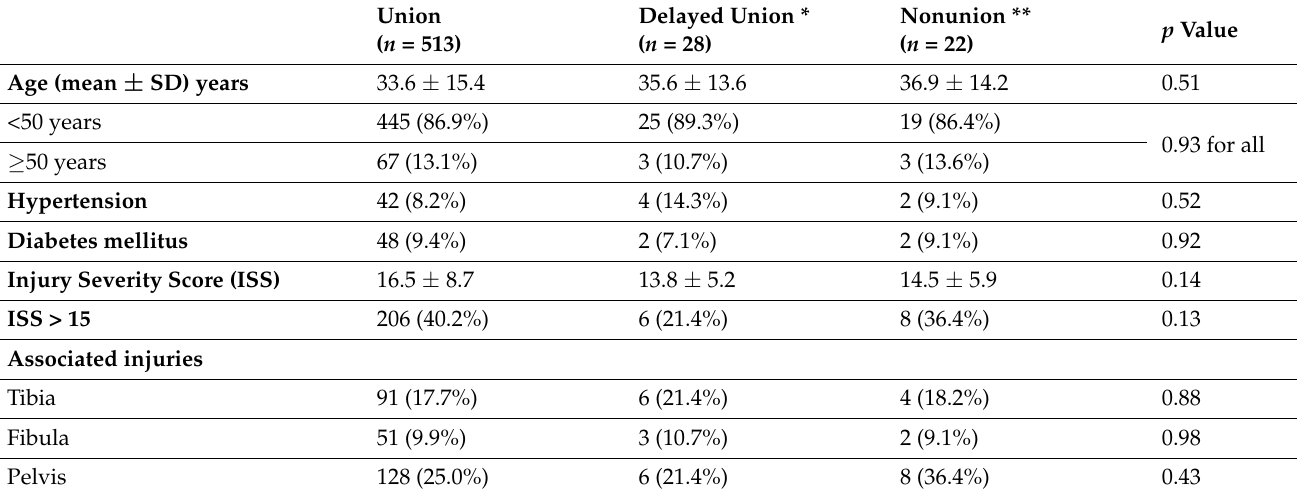
Figure 2. IMN timing and union outcomes. Table 4 compares the characteristics based on the postoperative outcomes of femoral shaft fracture. The three groups were comparable for age, co-morbidities, and associated injuries, pattern of femur fracture, time to IMN and the rate of wound infection. Those with nonunion of femur fracture were more likely to have bilateral fracture ( p = 0.003), frequently had retrograde nailing ( p = 0.01), and had high grade femur fracture (AO type C; p = 0.04) as compared to other groups. On the other hand, cases with union of fracture frequently had unilateral fractures ( p = 0.003), had antegrade nailing ( p = 0.005) and low-grade fractures (AO type A; p = 0.04). AO type B was observed in more cases who had delayed union ( p = 0.04). Table 5 depicts the management of femur fractures treated without IMN. Table 4. Characteristics based on the postoperative outcomes of femoral shaft